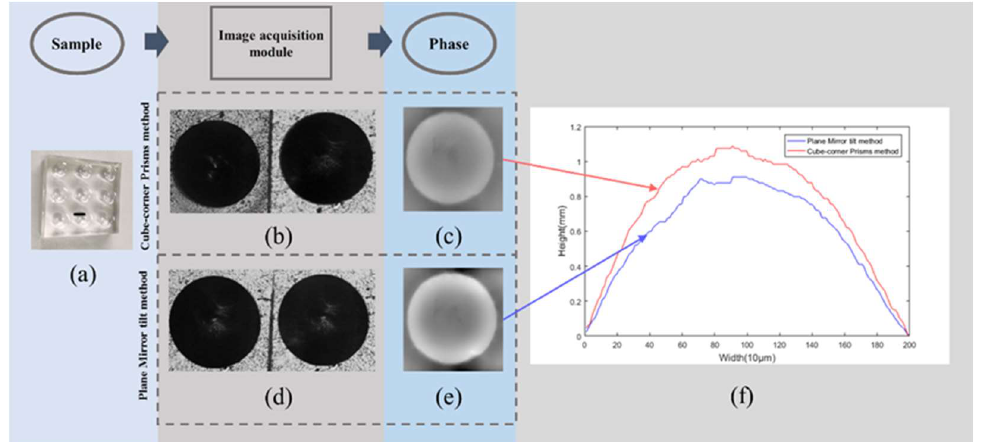
Figure 8. Experiments and results of micro-lens samples. ( a ) Micro-lens array; ( b ) Image taken by the cube-corner method; ( c ) Retrieval result of the cube-corner method; ( d ) Photographed by the plane mirror tilt method; ( e ) Retrieval result of plane mirror tilting method; and ( f ) Comparison result of depth value of transverse section